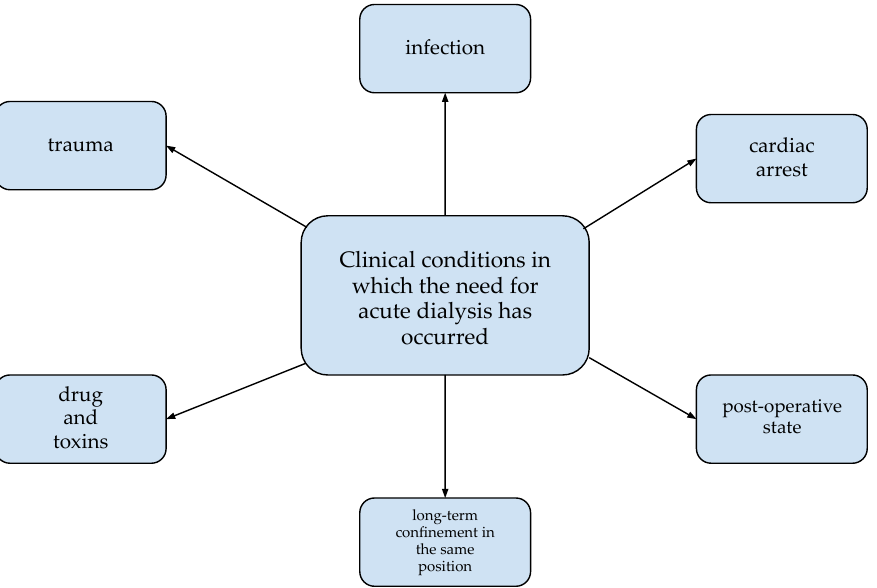
Figure 4. Clinical situations co-occurring with rhabdomyolysis in which the need for dialysis occurred